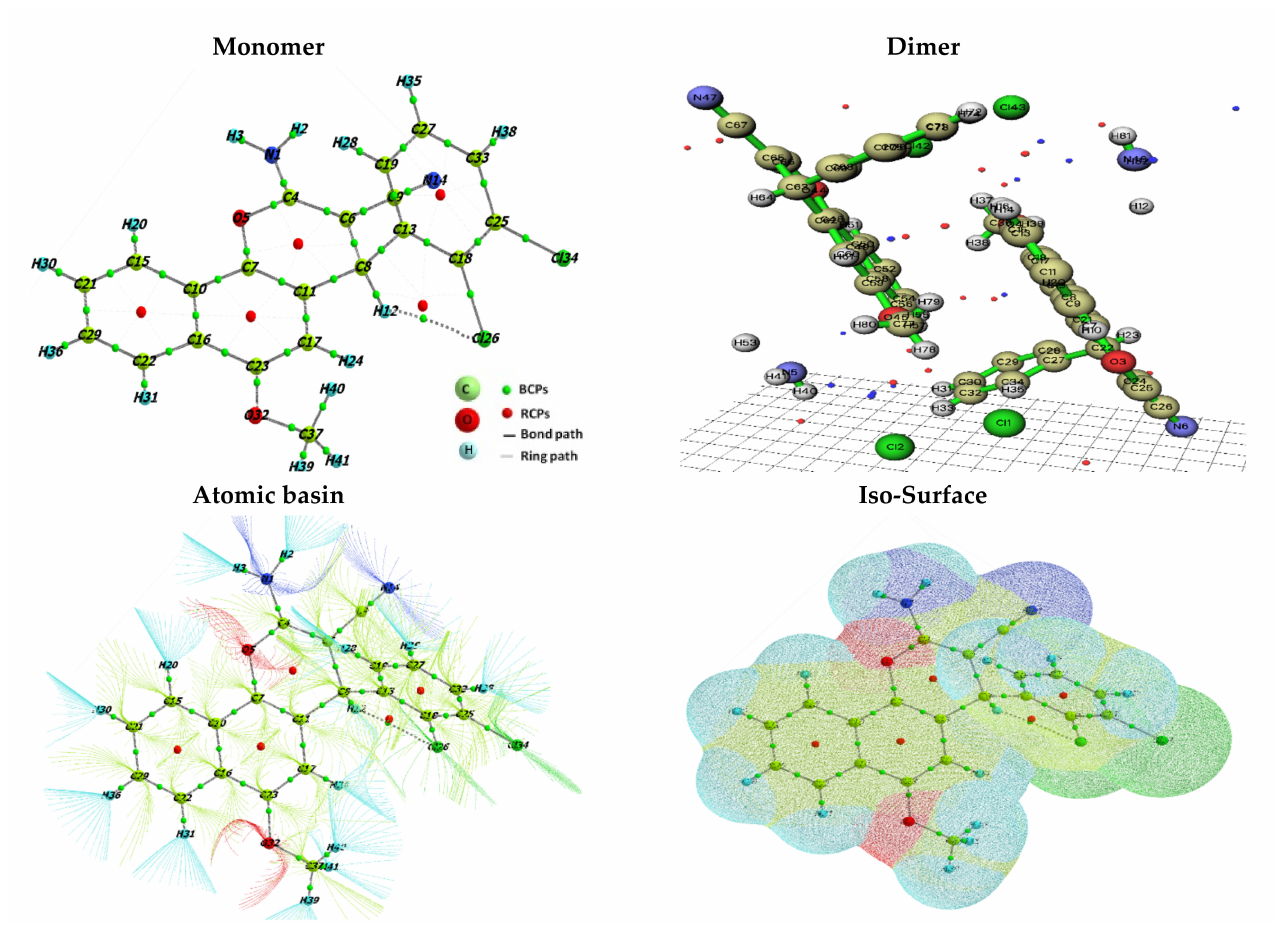
Figure 3. QTAIM molecular graph based on non-covalent